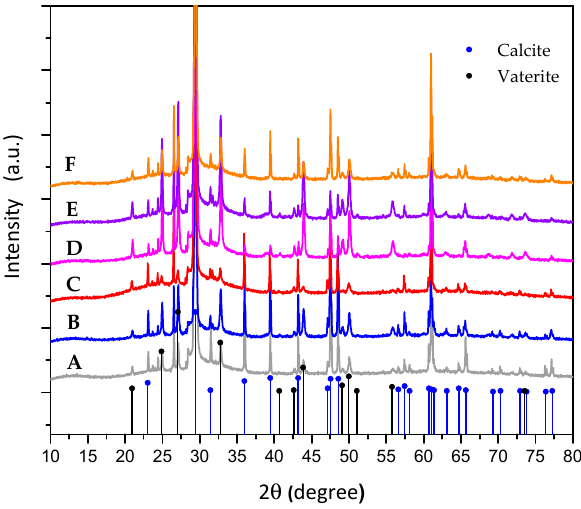
Figure 2. XRD pattern of CaCO 3 crystals obtained by GD crystallization: Control ( A ), ALG Les ( B ), MWCNT ( C ), MWCNT-OX ( D ), ALG Les /MWCNT ( E ) and ALG Les /MWCNT OX ( F ). Vertical blue line and black line designation in graph indicate calcite and vaterite standard peaks, respectively.